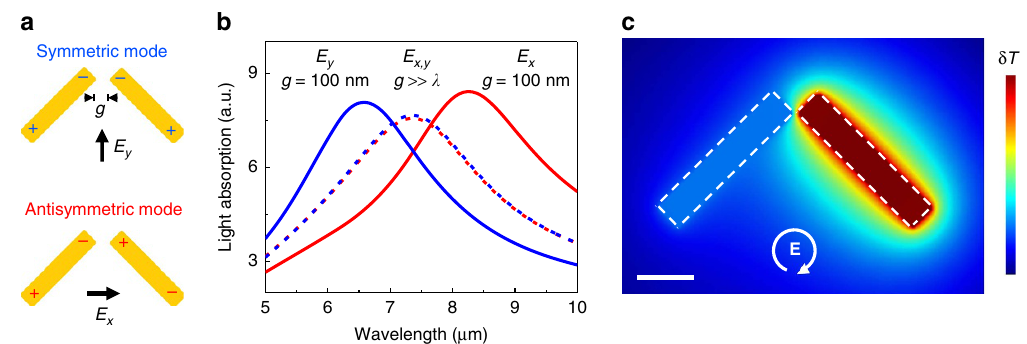
Figure 1 | Dimer antenna for circularly polarized light discrimination. ( a ) Basic dimer antenna geometry and associated symmetric (top) and antisymmetric (bottom) plasmon modes. The two rod antennas are positioned orthogonally to each other and are separated by a small gap g . ( b ) COMSOL-simulated absorbance of the dimer antenna for a for x - and y -polarized light illumination (red and blue lines, respectively) as a function of the light wavelength l . Solid lines are for g ¼ 100nm oo l , dashed lines are for g 44 l . ( c ) COMSOL simulation of the temperature distribution in the dimer antenna under RCP illumination at the resonant wavelength l ¼ 7.5 m m. For simplicity of calculations, the antenna is assumed to be positioned in air and d T is given in arbitrary units. Scale bar, 1 m m. (The temperature distribution in the dimer antenna under LCP illumination is the mirror image of that shown in c